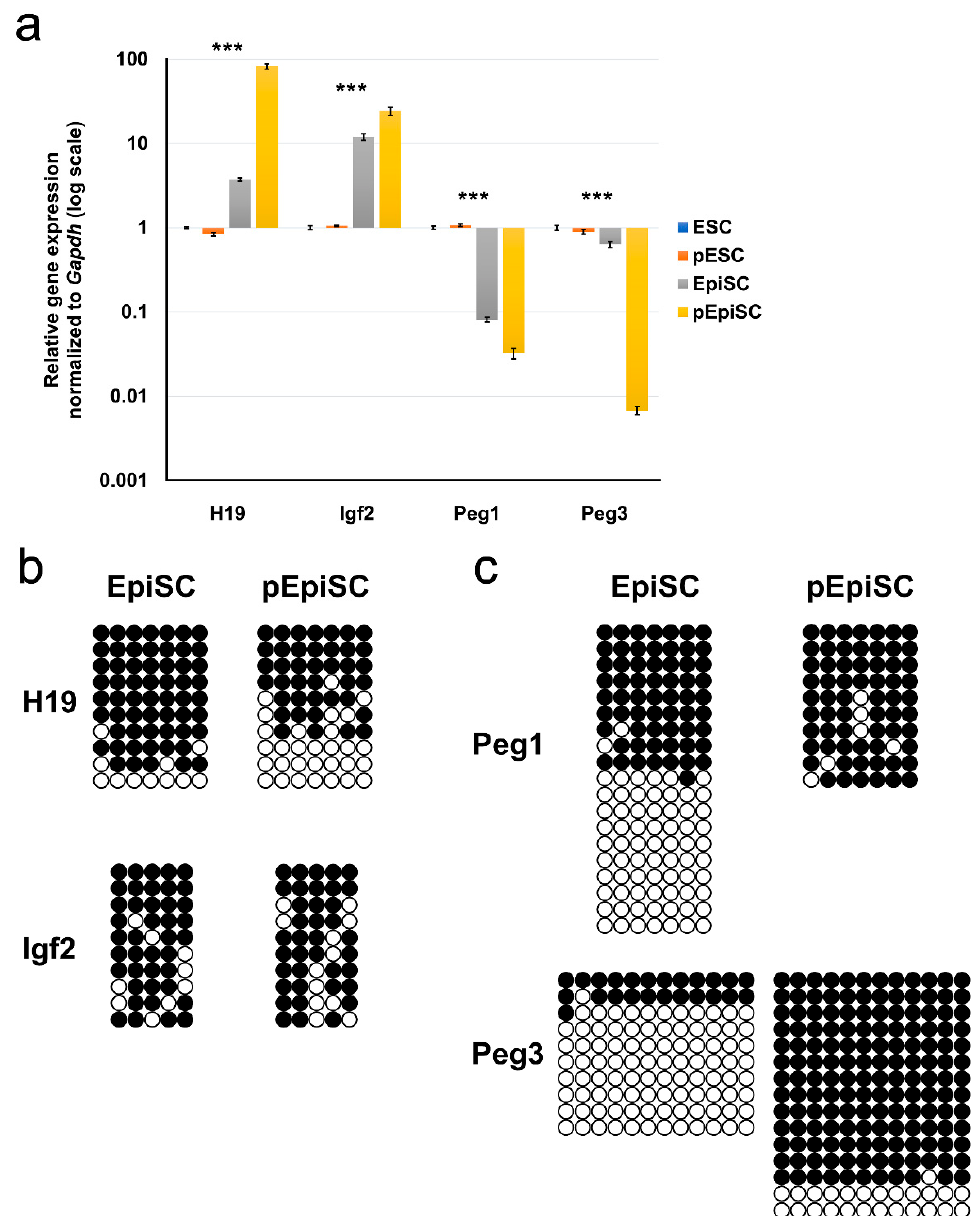
Figure 3. Expression and DNA methylation status of imprinted genes in parthenogenetic and biparental pluripotent stem cells. Analyses of imprinted gene expression and bisulfite genome sequencing. ( a ) Real-time RT-PCR analysis of pEpiSCs, EpiSCs, pESCs, and ESCs for paternally ( H19 and Igf2 ) and maternally ( Peg1 and Peg3 ) imprinted genes. ESCs and pESCs expressed similar levels of all four imprinted genes. H19 and Igf2 were expressed at higher levels in pEpiSCs than in EpiSCs (~22.11- and 2.03-fold, respectively), whereas Peg1 and Peg3 , were expressed at higher levels in EpiSCs than in pEpiSCs (~2.52- and 93.01-fold). Data are presented as the mean ± SEM for n = 3 independent experiments. *** p -value < 0.001. ( b ) Bisulfite DNA sequencing analysis of paternally imprinted genes ( H19 and Igf2 ) in pEpiSCs and EpiSCs. The DNA methylation level of H19 in pEpiSCs (~57.14%) was much lower than that in EpiSCs (~84.28%), whereas similar DNA methylation levels were observed in Igf2 (76% vs. 82%, respectively). Black and white circles represent methylated and unmethylated CpGs, respectively. ( c ) Bisulfite DNA sequencing analysis of paternally imprinted genes ( Peg1 and Peg3 ) in pEpiSCs and EpiSCs. Peg1 and Peg3 di ff erentially methylated regions (DMRs) were almost completely methylated in pEpiSCs; however, the EpiSCs displayed a di ff erentially methylated pattern (composed of completely methylated and completely unmethylated alleles) typical of imprinted genes in somatic cells. Black and white circles represent methylated and unmethylated CpGs,